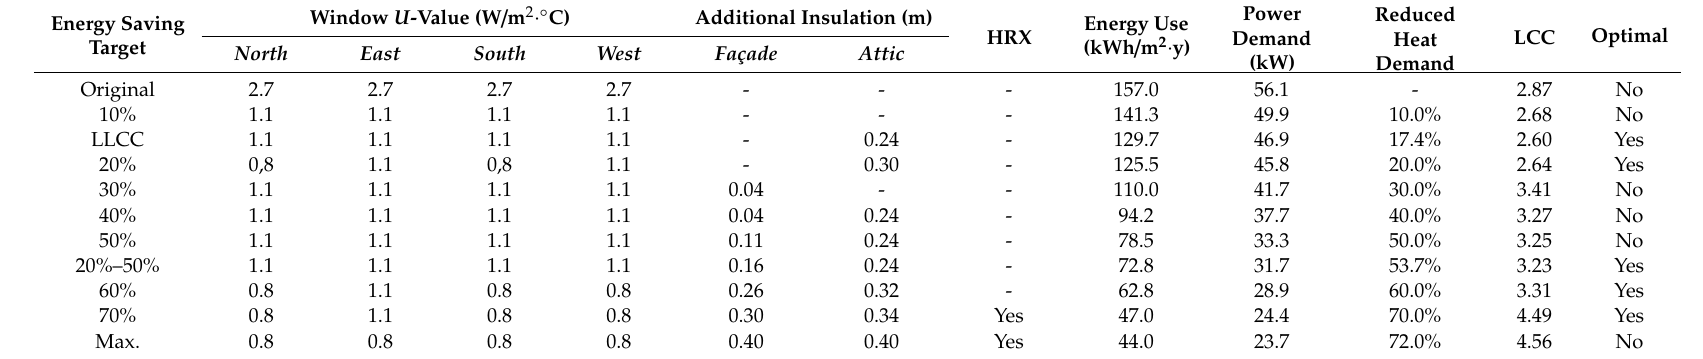
Table 15. EEMs at di ff erent energy saving targets between 10% and 70% for the 1950s